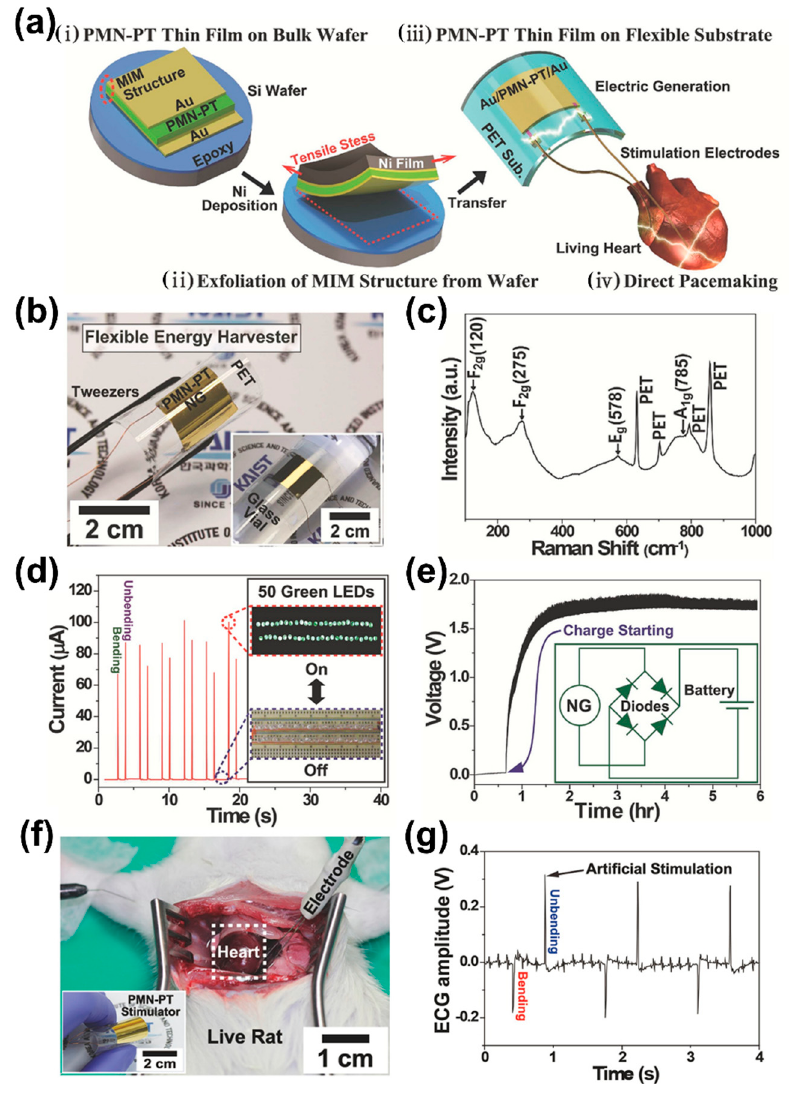
Figure 8. ( a ) Schematic diagram of the fabrication process and stimulating test on a living heart of a flexible PMN − PT film piezoelectric energy harvester. ( b ) Photograph of flexible PMN − PT film NG on PET substrate. The inset figure shows the harvesting device attached on a glass vial. ( c ) Raman vibrational spectrum of PMN − PT film. ( d ) The rectified current of flexible PMN − PT harvester. The inset presents the lighting of 50 green LEDs and corresponding current peaks during the bending and unbending of the harvester. ( e ) Charging response of a coin battery by PMN − PT energy harvester. The inset shows a schematic circuit diagram for energy storage comprising four diodes and a battery. ( f ) Photograph of opened chest of living rat to stimulate its heart. A flexible PMN − PT film stimulator (inset). ( g ) The ECG amplitude of stimuli by bending and unbending of the flexible energy harvester. Reproduced with permission [27].